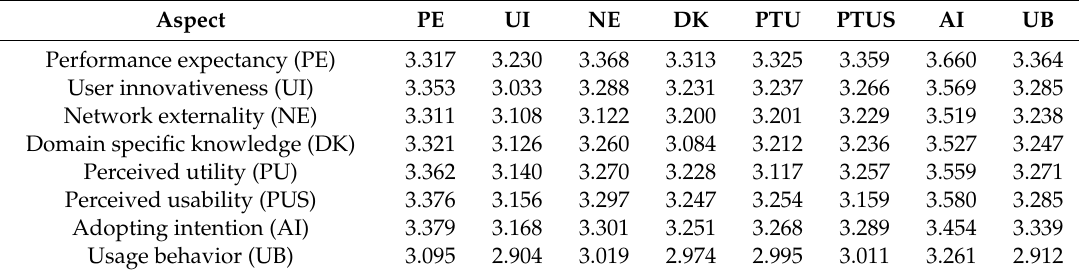
Table A5. The total influence matrix T .